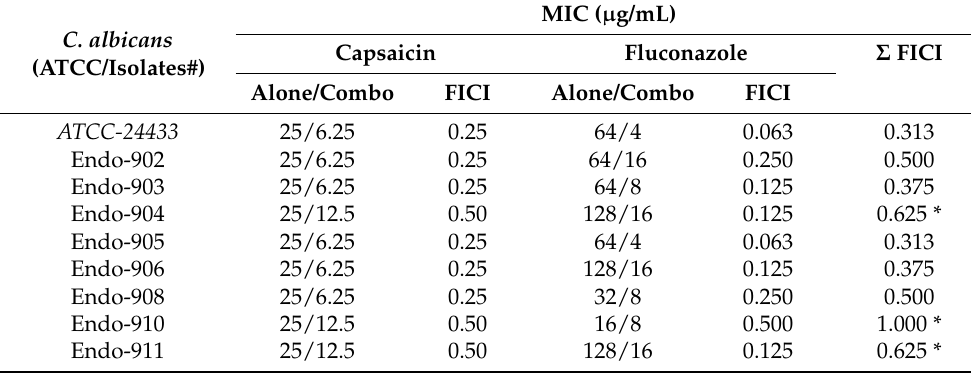
Table 2. Antifungal effects of Capsaicin alone and in combination with Fluconazole against C. albicans